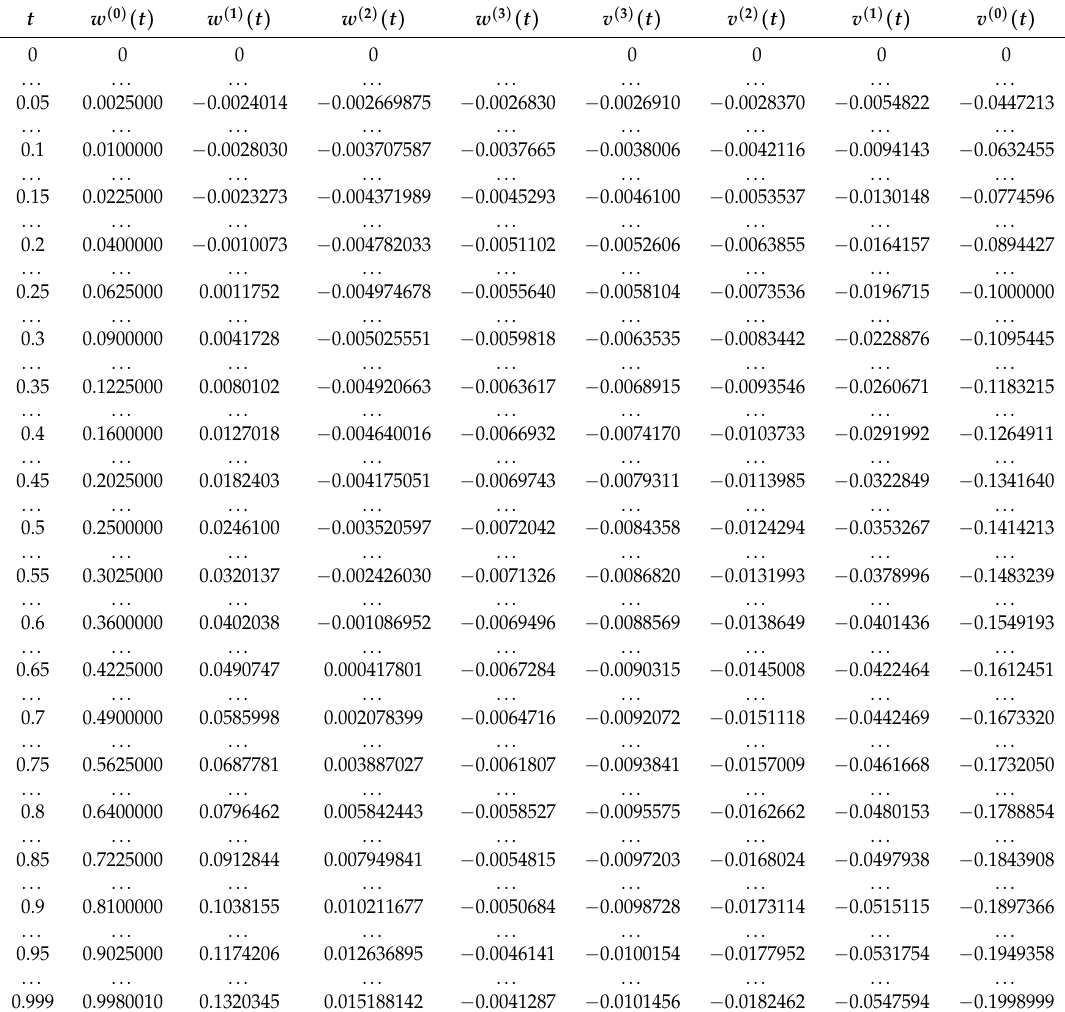
Table 1. Values of successive approximations w ( n ) ( t ) and v ( n ) ( t ) , n = 0, 1, 2, 3 for t ∈ [ 0,1 ]